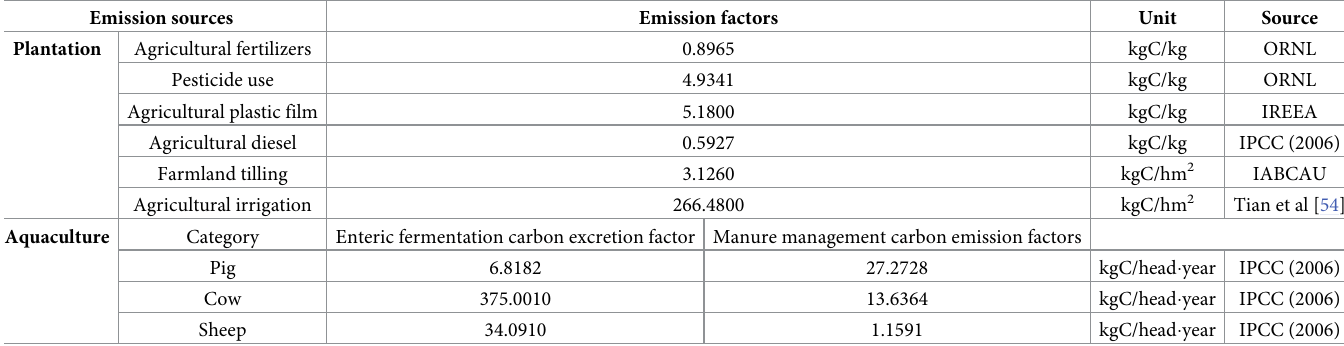
Table 2. Emission factors for the main sources of carbon emissions from agriculture in the